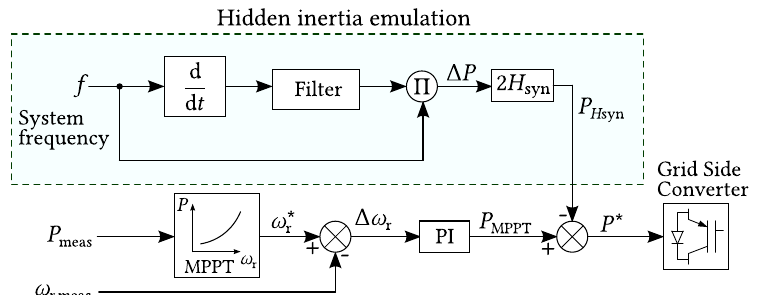
Figure 11. Controller for releasing hidden inertia.